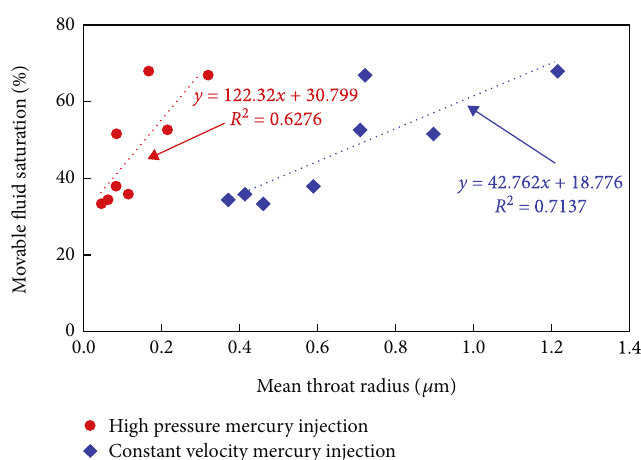
Figure 18: Relationship between mean throat radius and movable fl uid saturation.